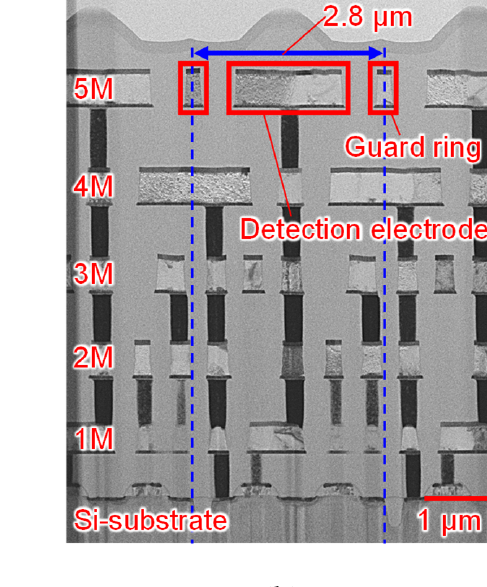
Figure 6. The cross-sectional pixel TEM image of the two chips: ( a ) Chip A; ( b ) Chip B. cated sensor chip mounted face-up, an analog front-end (AFE) circuit board with voltage regulators and a 14-bit differential ADC directly connected to V OUTN and V OUTS , a FPGA board to supply operation pulses to the sensor chip, and a PC. A function generator was used to apply ϕ C to the counter electrode, and a trigger signal was input from the FPGA to synchronize with the sensor operation. The function generator alone could generate ϕ C up to V IN = 20 V, and the sensor was measured at a maximum of V IN = 300 V using a high-speed high-voltage amplifier.